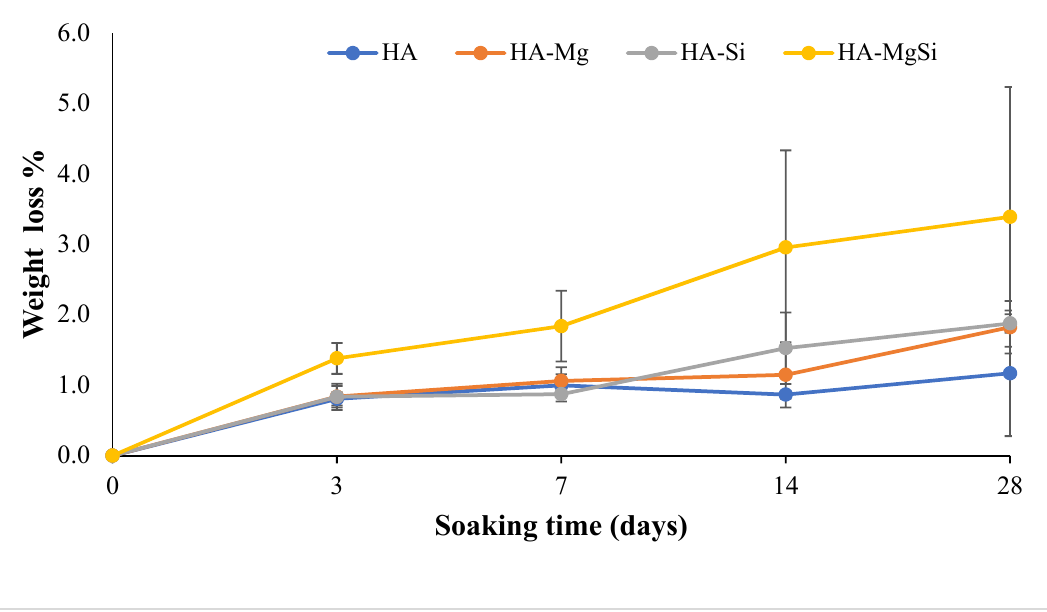
Figure 6. Plot of percentage of weight loss during soaking in Tris-HCl. Average values with standard deviations are reported (n = 6).